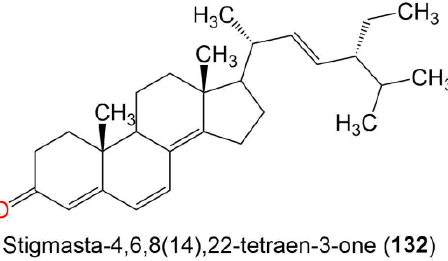
Figure 14. Structures of sterols ( 126 – 132 ) isolated from F. oxysporum . Isoverrucarol ( 133 ), a trichothecene was isolated from F. oxysporum CJS-12, harboring corn produced toxic effects (dose 10 and 20 mg/kg/b.wt., orally) in rats, including body weakness, loss of appetite, stomach severe mucosae, and death. It also caused a definite dermatitis reaction of the epidermis and an edematic-necrotic response of the dermis [100]. FCRR ( 134) a new phytotoxin, having a labdane framework was purified from F. oxysporum f. sp. radicis-lycopersici (causal agent of Fusarium rot and crown rot of tomato). It (conc. 0.25 µ g/mL) induced leaf necrosis for Momotaro (a cultivar of tomato, Lycopersicon esculentum Mill.) [101]. Chen et al., separated and characterized two novel compounds, fusariumins C ( 135 ) and D ( 136 ) from F. oxysporum ZZP-R1 derived from Rumex madaio . They were assigned as a meroterpene with cyclohexanone unit and a sesquiterpene ester with a conjugated triene and an unusual oxetene ring, respectively based on